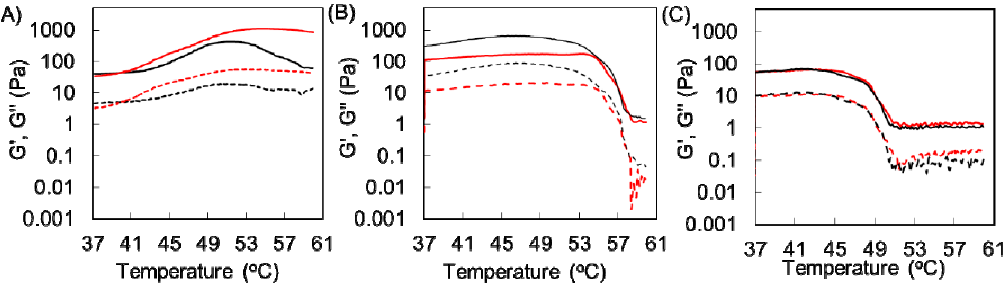
Figure 6. Rheological analysis of di ff erent collagen gels with and without AuNP (red and black). ( A ) Figure 6. Rheological analysis of different collagen gels with and without AuNP (red and black). ( A ) Cellmatrix type I-A, ( B ) Atelocell IAC, and ( C ) Cellmatrix type I-C. G’ and G” are shown as solid and Cellmatrix type I-A, ( B ) Atelocell IAC, and ( C ) Cellmatrix type I-C. G’ and G’’ are shown as solid and dotted lines, Figure 6. Rheological analysis of different collagen gels with and without AuNP (red and black). ( A ) dotted lines, respectively. Cellmatrix type I-A, ( B ) Atelocell IAC, and ( C ) Cellmatrix type I-C. G’ and G’’ are shown as solid and Figure 6. Rheological analysis of different collagen gels with and without AuNP (red and black). ( A ) dotted lines, respectively. Cellmatrix type I-A, ( B ) Atelocell IAC, and ( C ) Cellmatrix type I-C. G’ and G’’ are shown as solid and dotted lines, respectively.